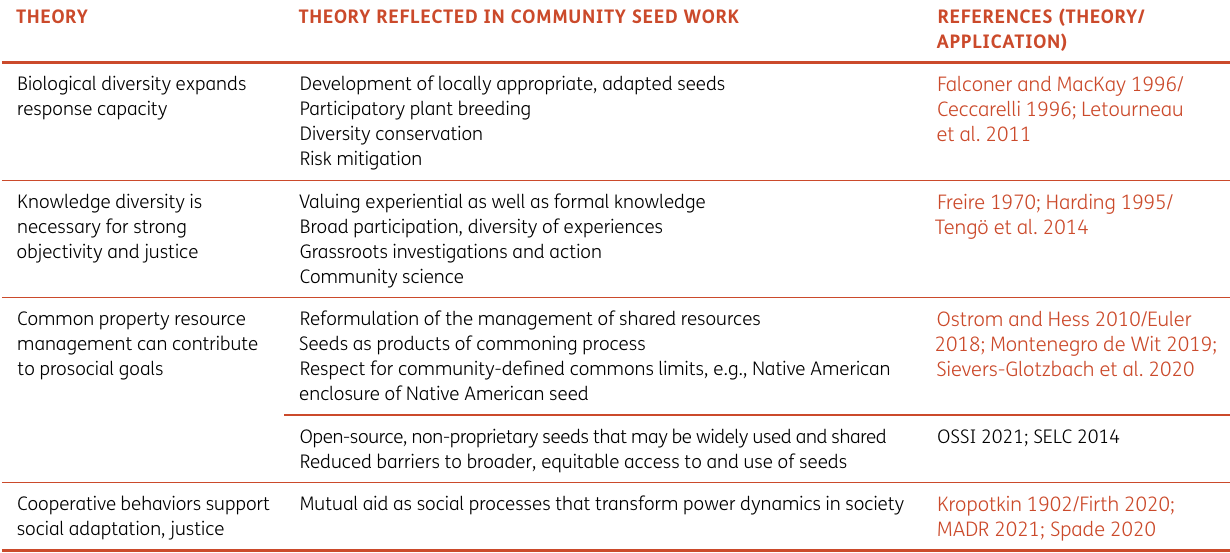
Table 1 Key theories for the work of some community seed organizations in the United